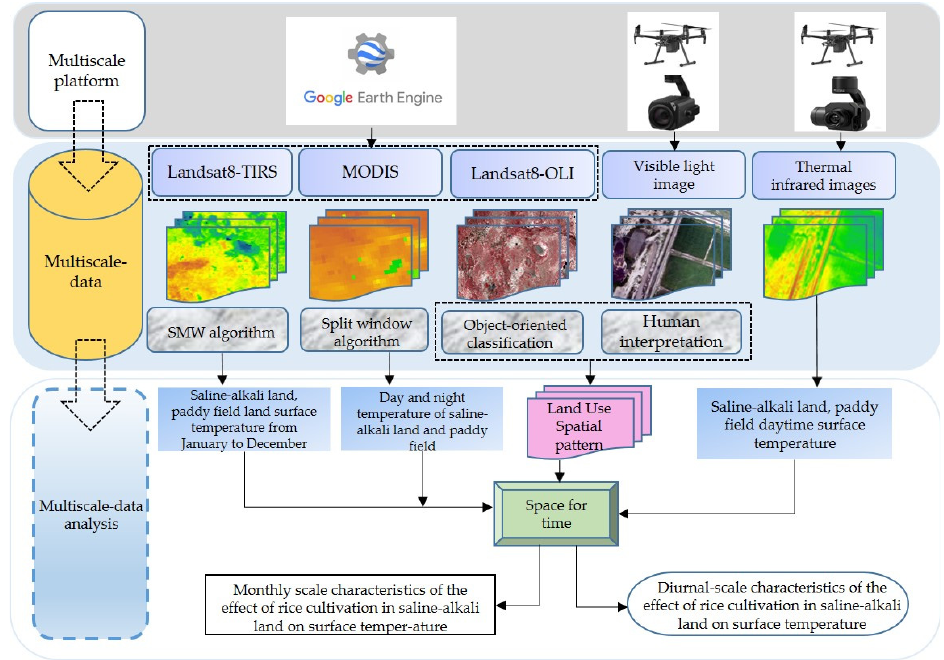
Figure 2. The study framework for investigating the multisource surface temperature impact due to saline–alkali land greening.